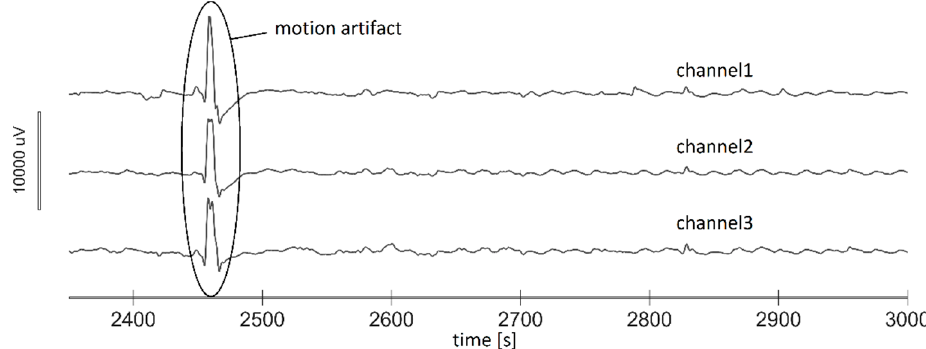
Figure 3. EGG signal with a large spike as a result of a movement artifact (in circle).